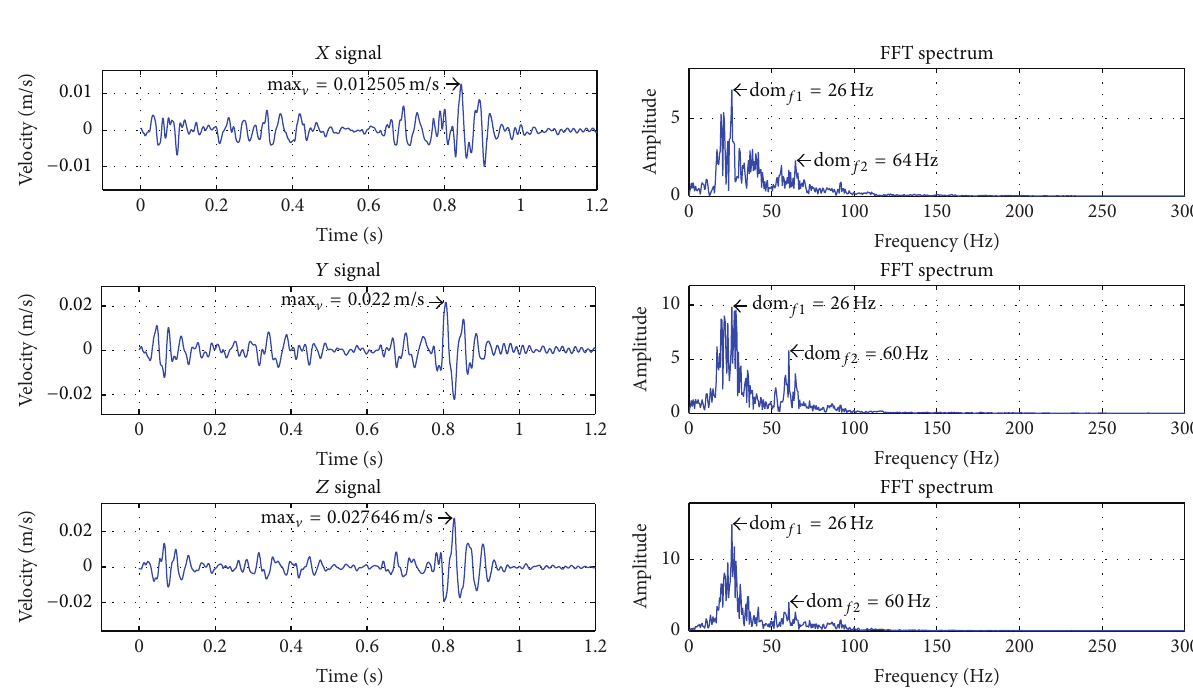
bottom point to 2.765 cm/s at land point. The horizontal vibration peak amplitude attenuates 87.05% at 𝑥 -axis and 62.75% at 𝑦 -axis separately. The duration time of water bottom vibration is 0.9 s but that of the land vibration is almost 0.95 s. The time of peak amplitude delays 0.2 s from water bottom point to land point. The land